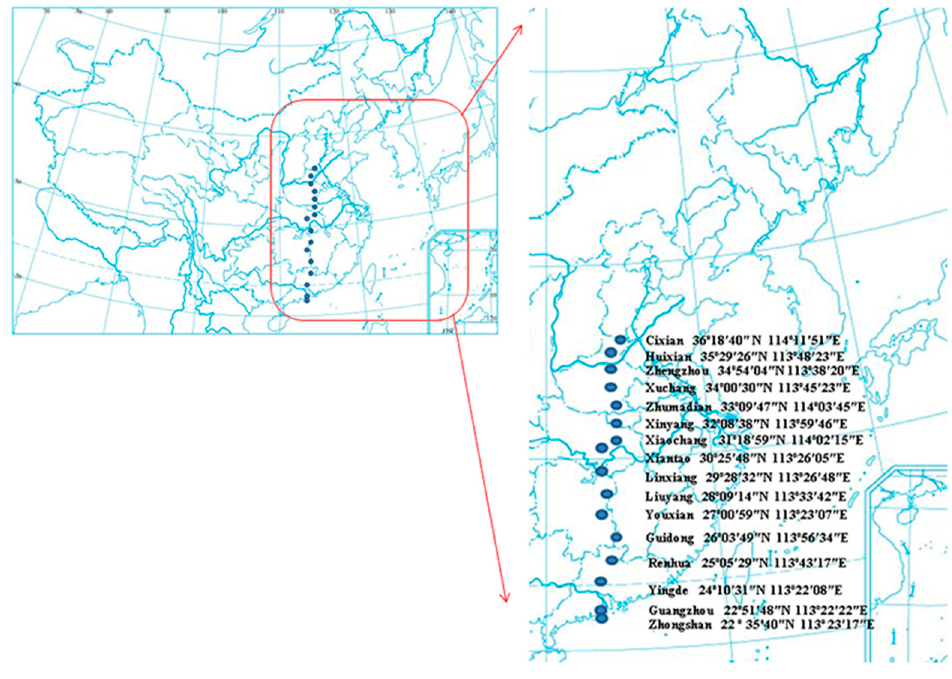
Figure 1. Distribution of the C. dactylon (L.) Pers. accessions collected along a latitudinal gradient from 22°35’ N to 36°18’ N of China. The latitude and longitude of the 16 populations are indicated on the figure which was generated by Sigmaplot 10.0.1 (Systat Software Inc., San Jose, CA, USA). Table 1. Expressed sequence tag-simple sequence repeat (EST-SSR) primers are shown for each primer pair including forward and reverse sequence, repeat type, expected size (bp), GenBank accession number and annealing temperature.